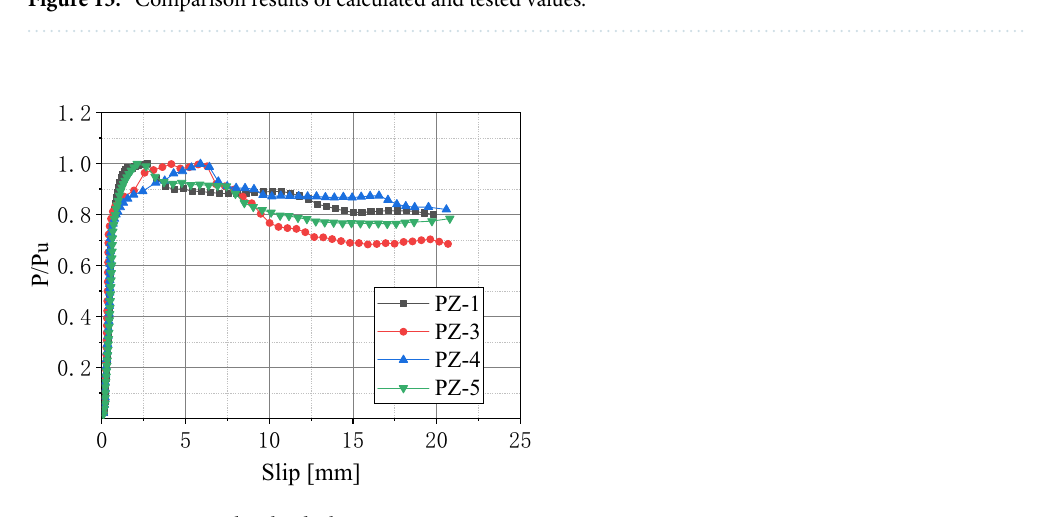
Figure 14. Dimensionless load–slip